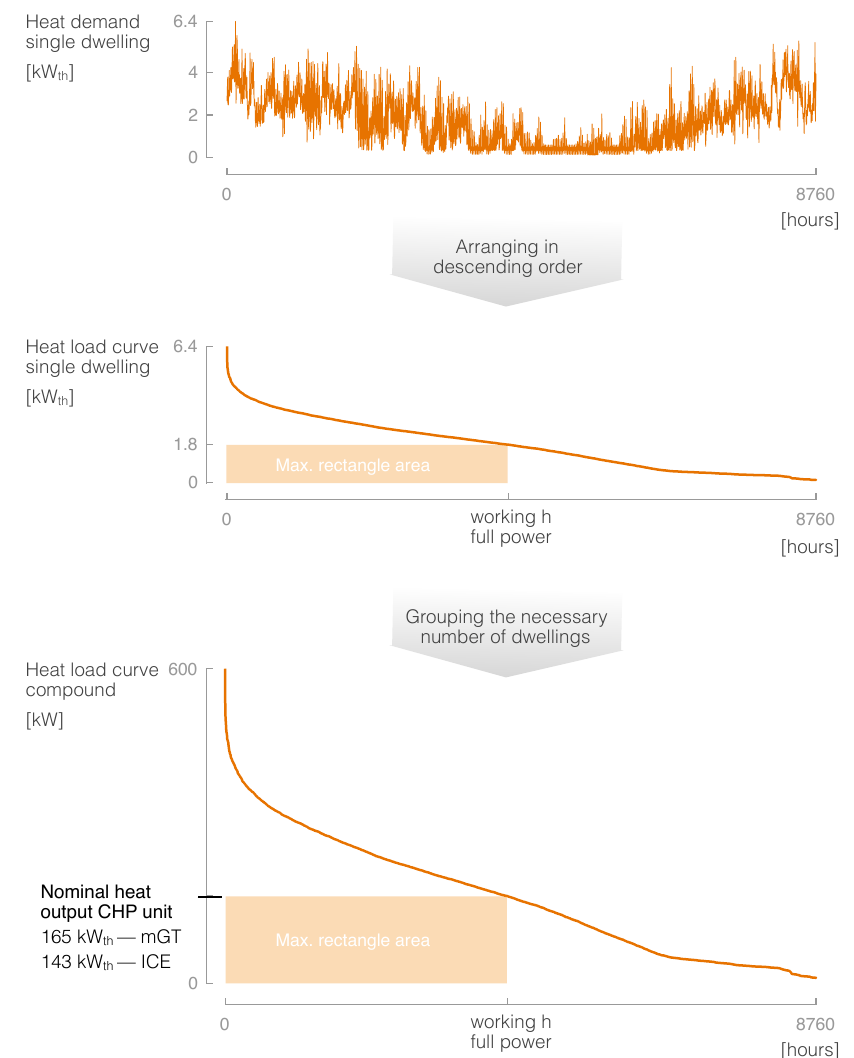
Figure 8. The demand sizing procedure consists of grouping dwellings so that the maximum rectangle area under the heat load curve has a height equal to the nominal heat output of the CHP